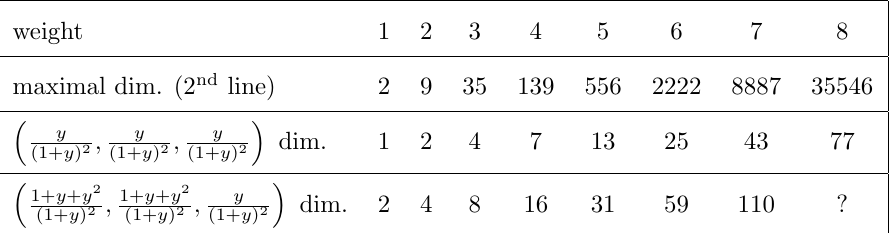
Table 18 . Dimensions of H hex when restricted to two lines with symbol letters y; 1+ y; y (cid:0) !; 1 (cid:0) (cid:22) ! , for weights up to 8. The maximal dimension corresponds to allowing all MZVs and all cyclotomic HPLs with no branch cuts on ( u; u; 1 (cid:0) u ) other than at u = 0 ;